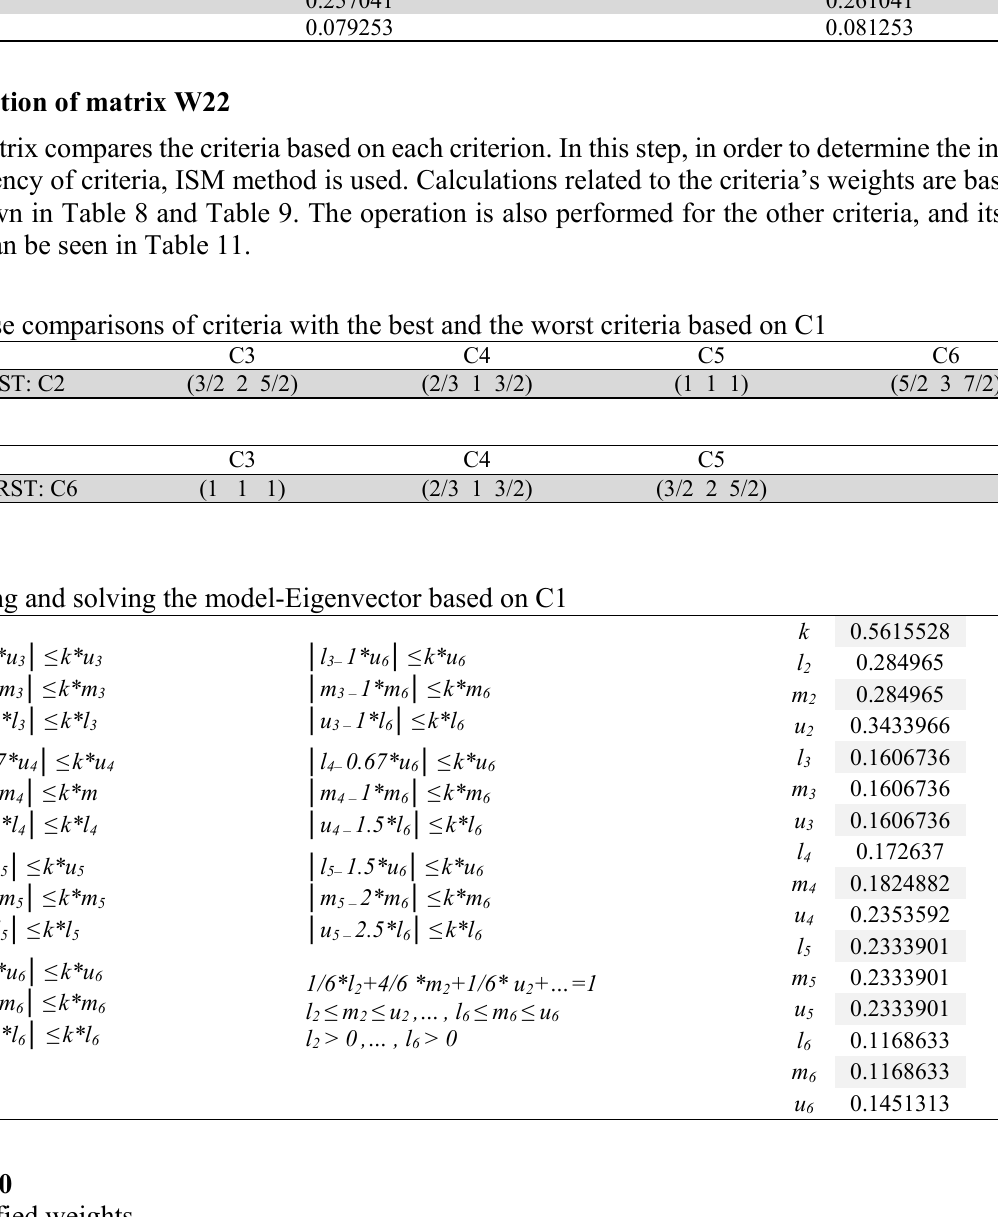
Deffuzified weights